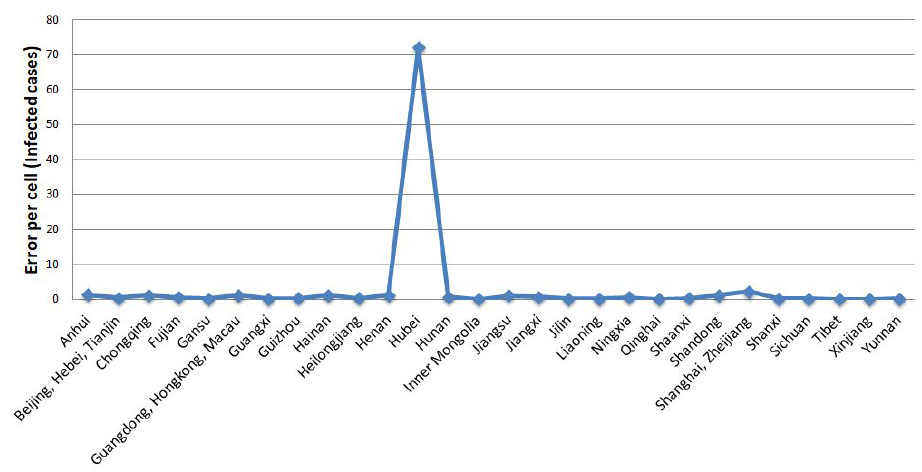
Figure 11. The average error per cell of the model fit for each region.